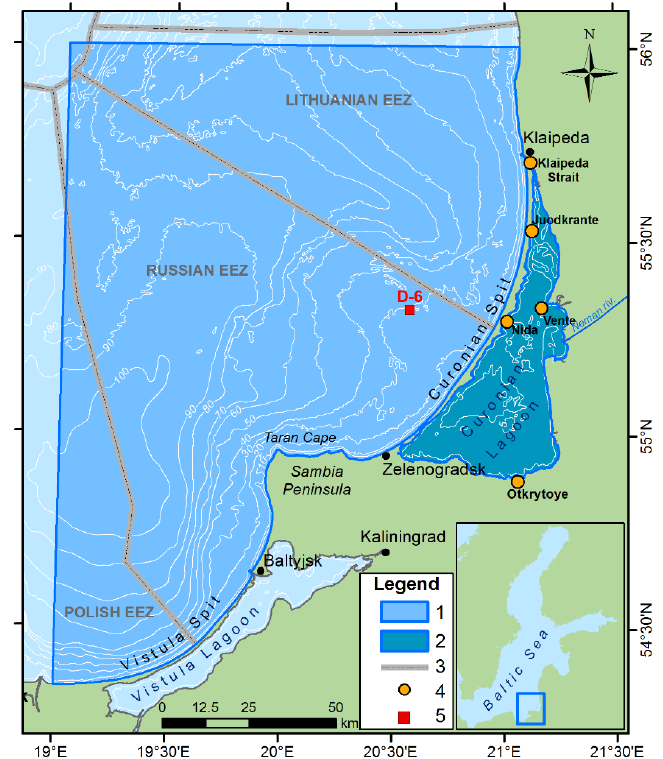
Figure 1. Map of the study area. Legend: 1—marine part of the study area; 2—the Curonian Lagoon; 3—boundaries of exclusive economic zones (EEZ); 4—ice monitoring stations in the Curonian Lagoon; 5—D-6 oil platform. The contour lines show isobaths.